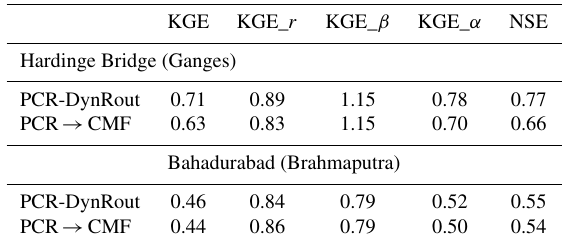
Table 2. Assessment of performance of PCR, PCR → CMF, and PCR → CMF → LFP runs at both Hardinge Bridge (Ganges) and Bahadurabad (Brahmaputra); the coloured boxes indicate best per- formance compared to other